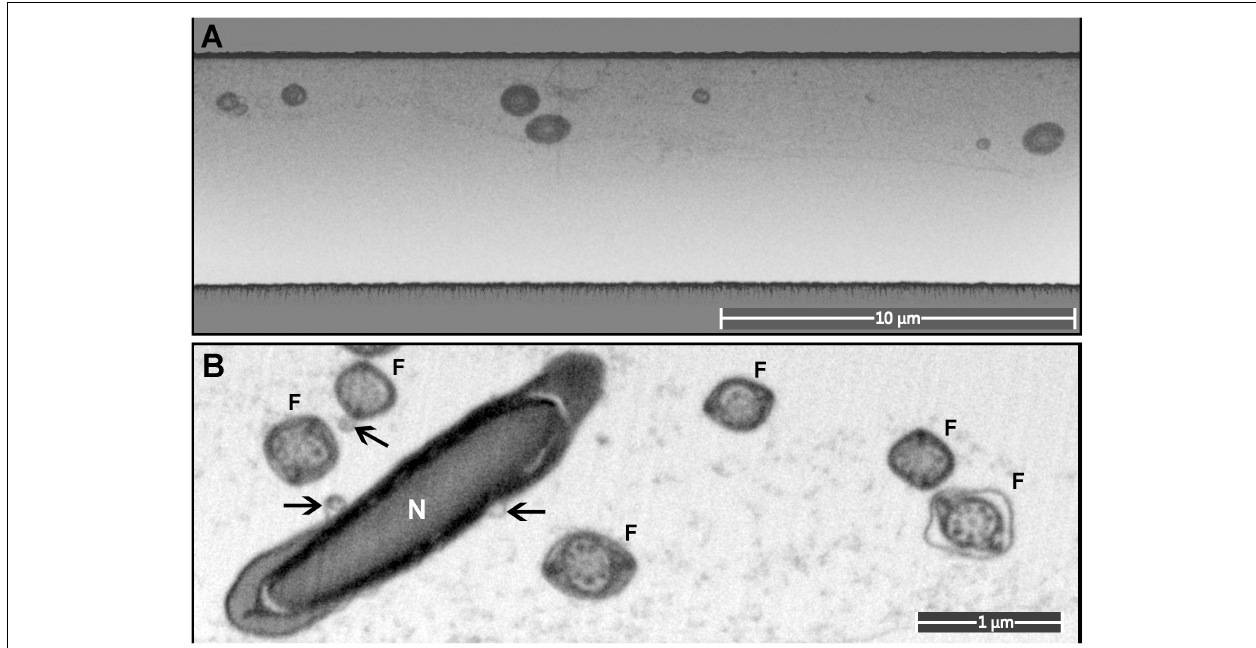
FIGURE 7 | A monolayer of mouse sperm on the top surface of a resin block used for FIB-SEM. (A) An image of a trench on the surface of the FIB-SEM block (low magnification). (B) Cross-sections of sperm flagella (F) and nucleus (N). Exosome-like structures are marked with arrows.